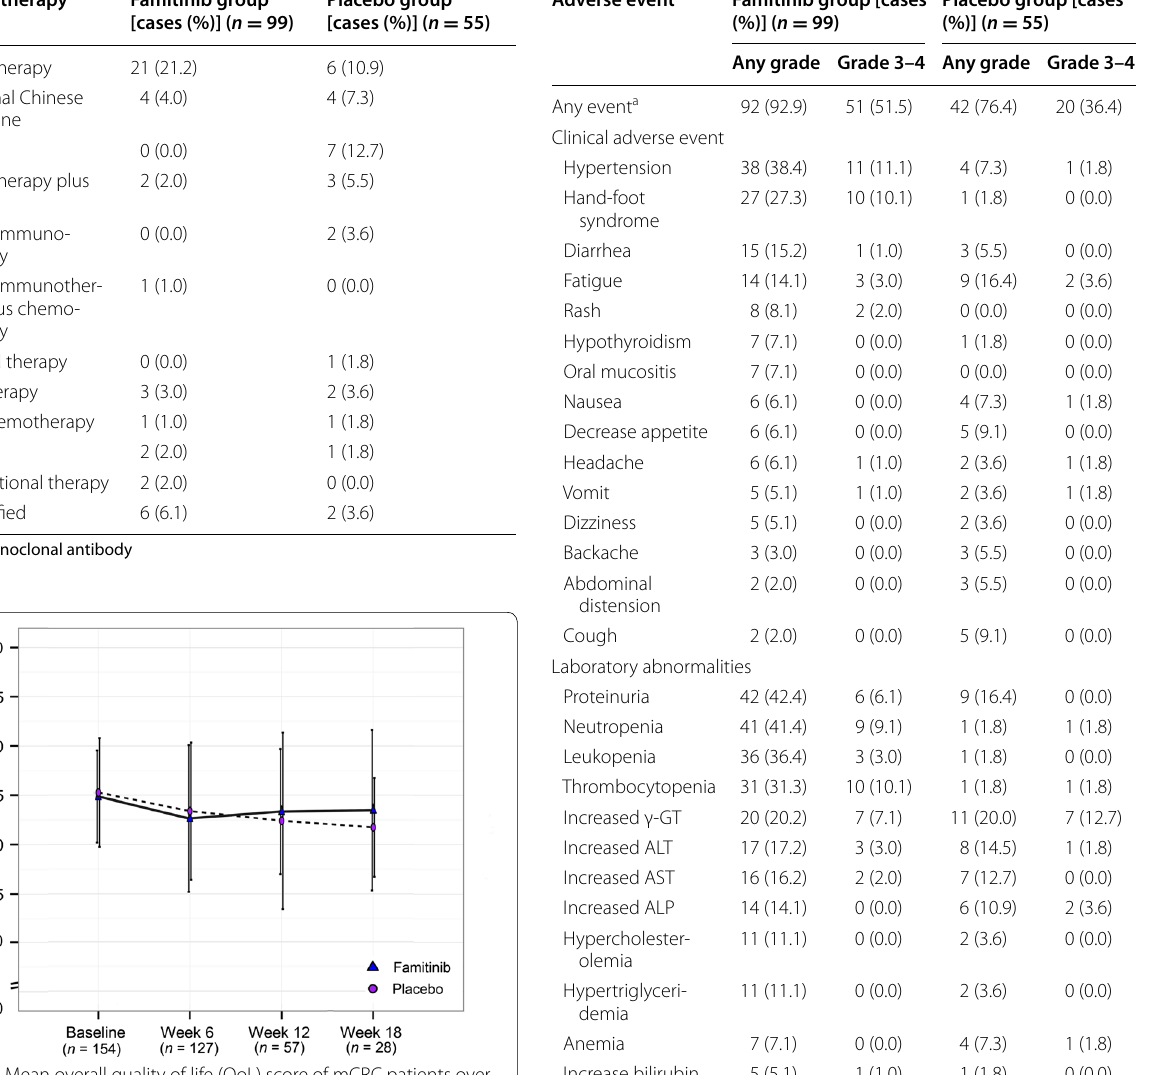
Fig. 4 Mean overall quality of life (QoL) score of mCRC patients over early study visits at baseline and during famitinib or placebo treat‑ ment. All data points are presented as mean